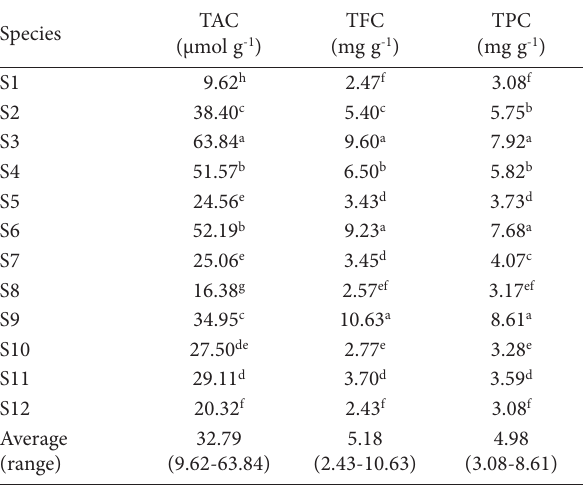
Table 4. Information obtained from phytochemical evaluation of studied 12 berry species. Total Antioxidant Capacity (TAC), Total Flavonoid Content (TFC), Total Phenol Content (TPC). In each column, means with the same symbol letter are not significantly different (P > 0.01), using LSD